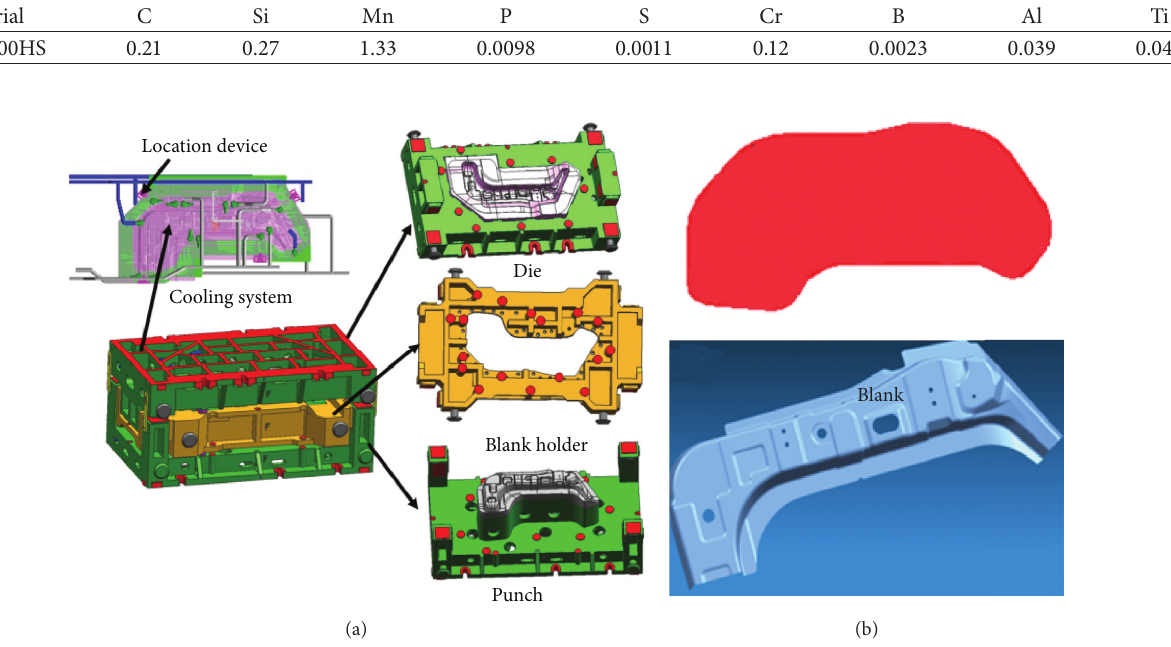
Figure 1: (a) Mold structure; (b) blank and formed part.